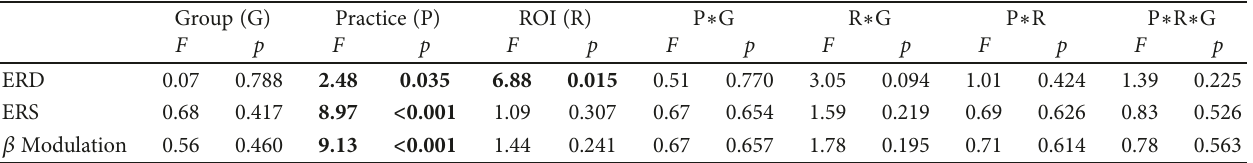
Table 2: Results of mixed model univariate ANOVAs for the magnitude of ERD and ERS and beta modulation depth. Group